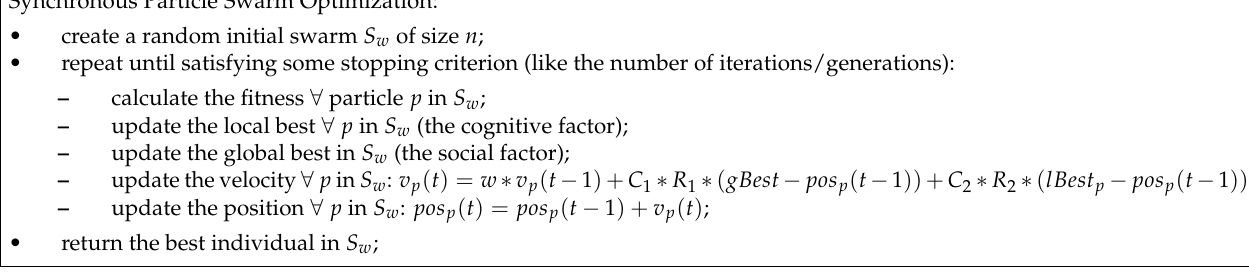
Figure 8. Procedural steps of